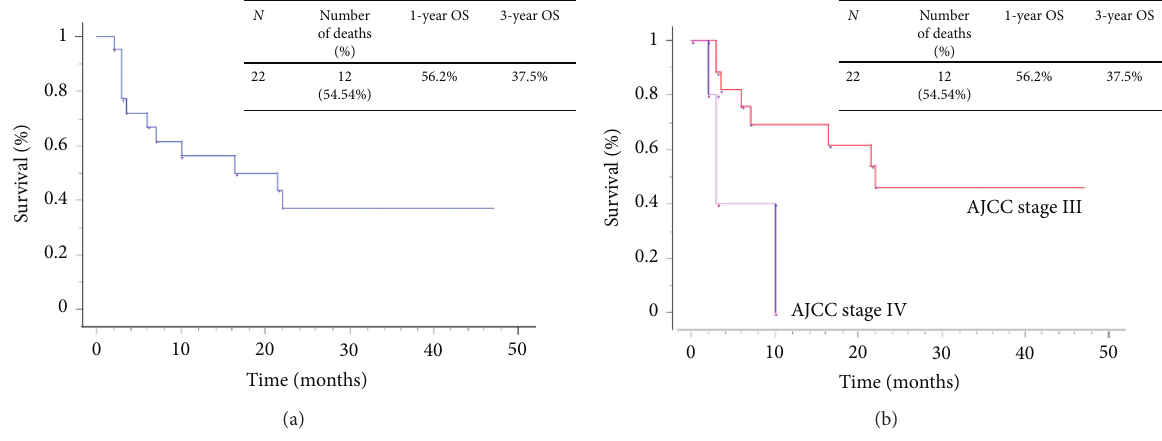
Figure 5: The overall survival